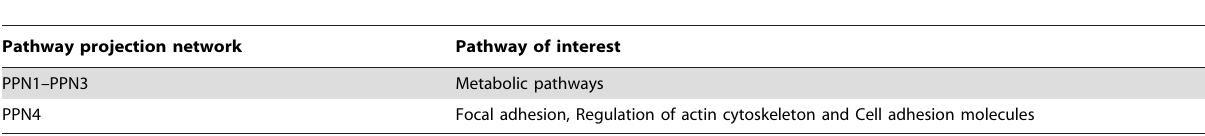
Table 5. Pathways of interest in each